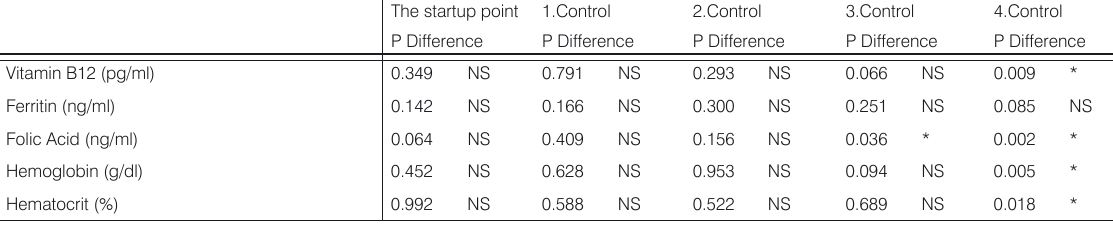
Table 4. Statistical Comparison of Blood Analysis Results for Group I and Group